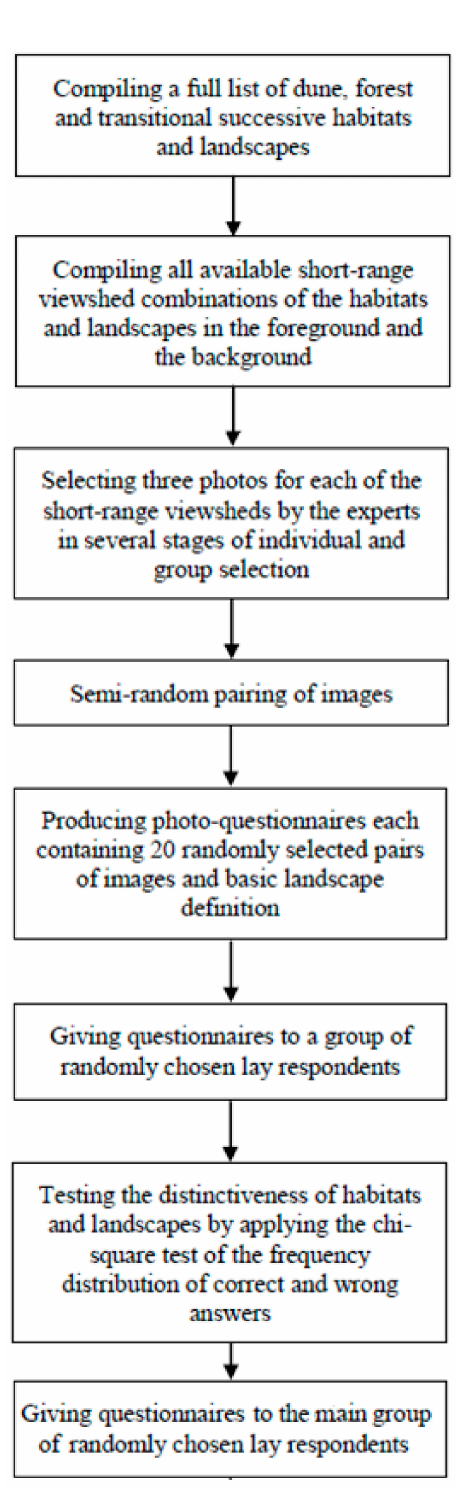
Figure 3. Research flow